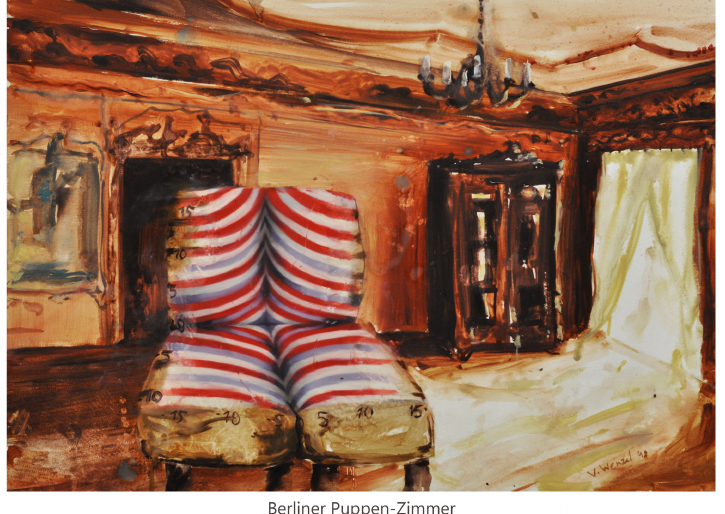
Figure 4. ( p , q ) -circles for ( p , q ) = ( 0.2,3/4 ) and several values of r ( Berliner Puppen-Zimmer , Oil on paper, 30 ×